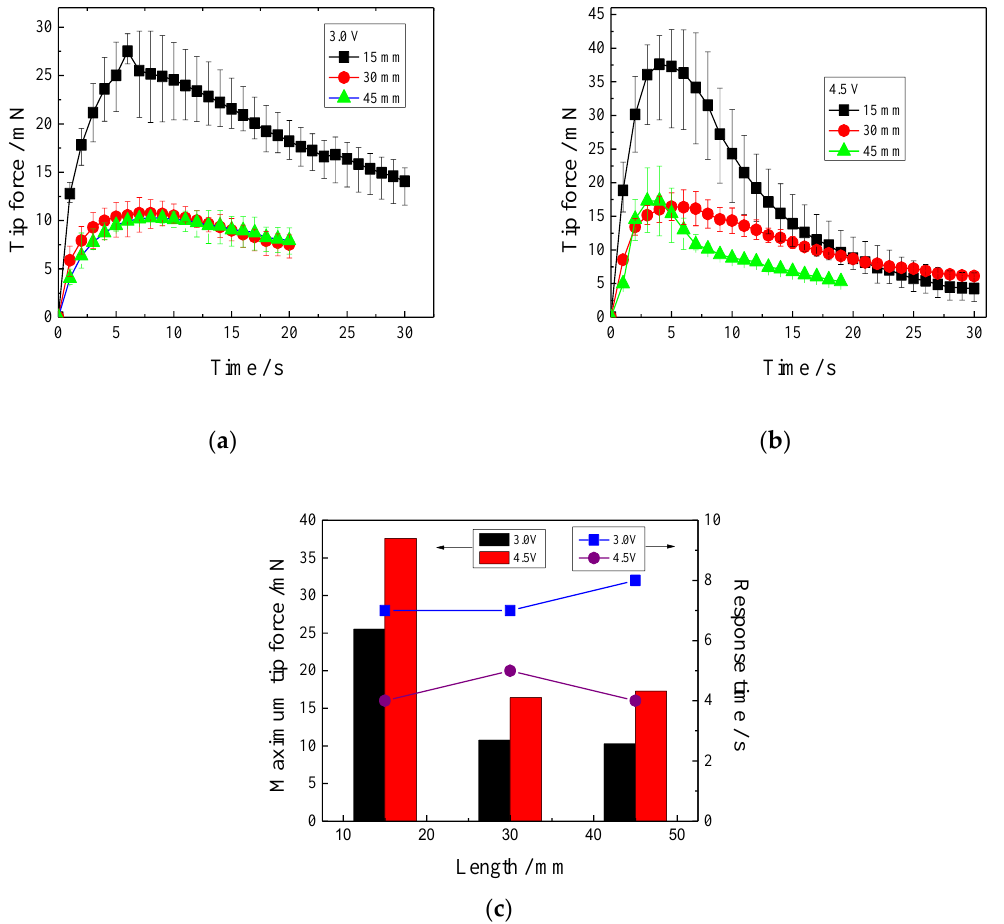
Figure 7. Tip forces of the IPMCs, with various lengths under different voltages. ( a ) 3.0 V; ( b ) 4.5 V; ( c ) relationships between the maximum tip forces, or the response times and lengths.